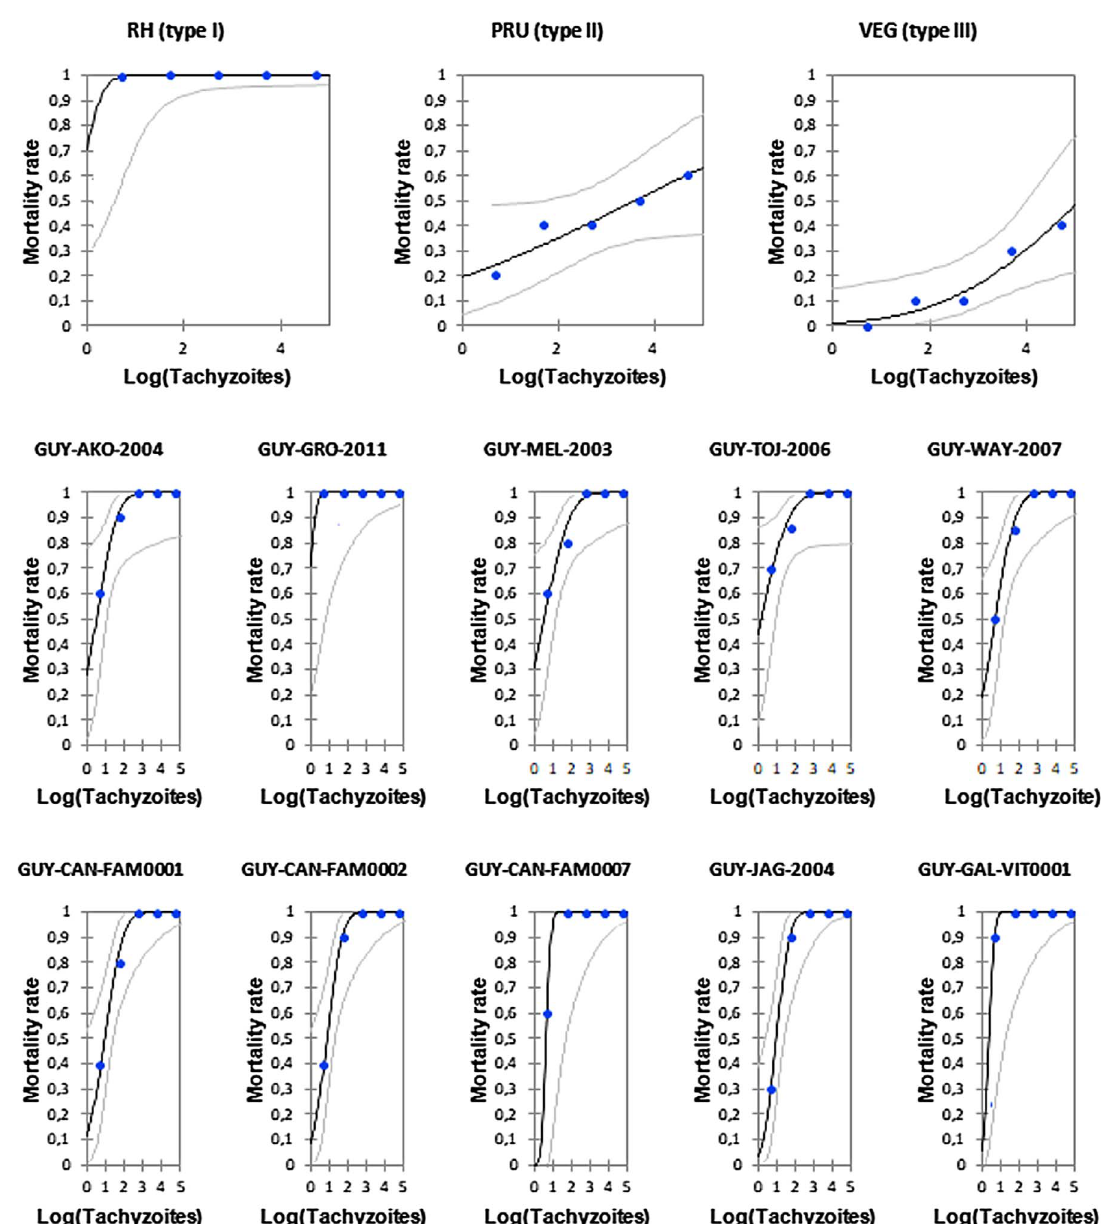
Figure 2. Determination of LD 50 and LD 99 for the 10 atypical strains of Toxoplasma gondii compared to reference strains (type I, II and III). Dose effect curves using a Probit model (black). Con fi dence interval (95%) curves are also shown (grey). On top of the fi gure, the tree reference strains (I, II and III) are shown for comparison.